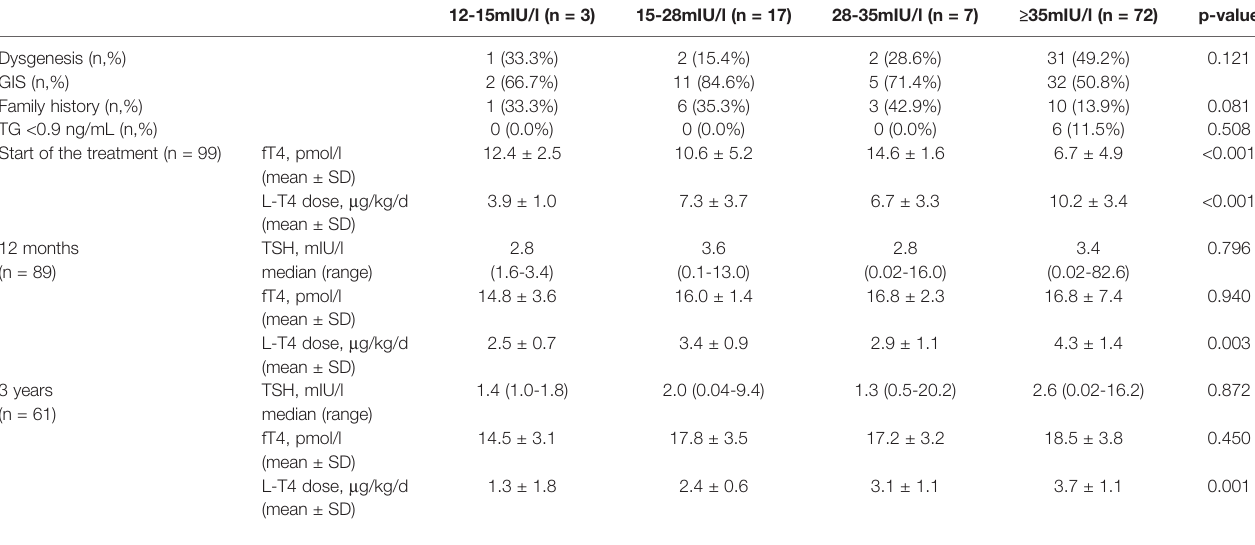
TABLE 6 | Initial characteristics, thyroid function tests, and levothyroxine dosage in subgroups in relation to the previous TSH threshold values.